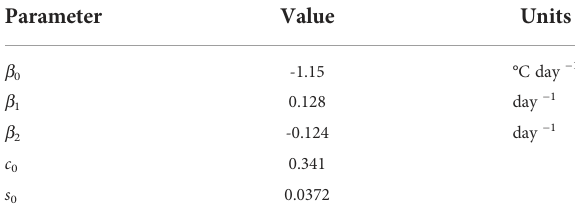
TABLE 3 Optimized values of the parameters in the model for SST (Equation